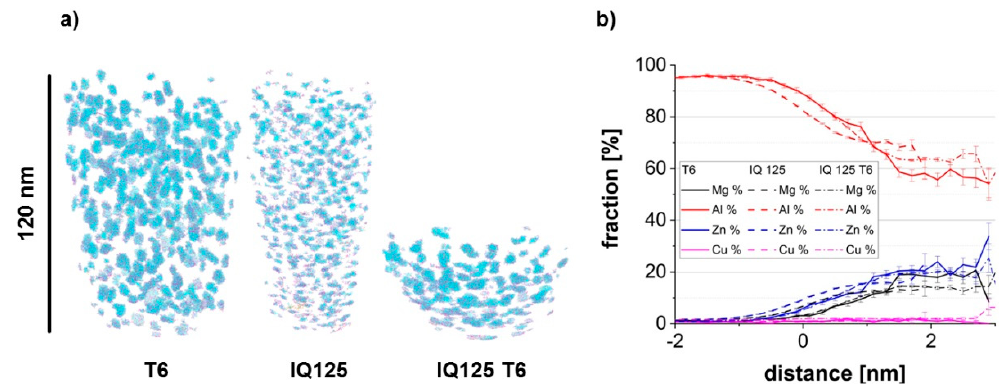
Figure 6. ( a ) Three-dimensional (3D) reconstructions of the atom positions for identified precipitates via the cluster search. ( b ) Proximity histogram deduced from Mg-Zn iso-surfaces at 10 at% for Al (red), Zn (blue), Mg (black) and Cu